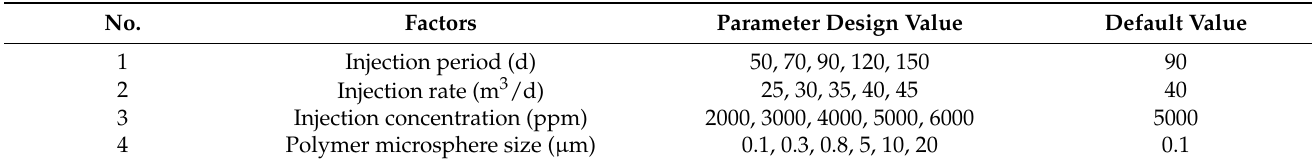
Table 1. Parameters and design values for sensitivity analysis.